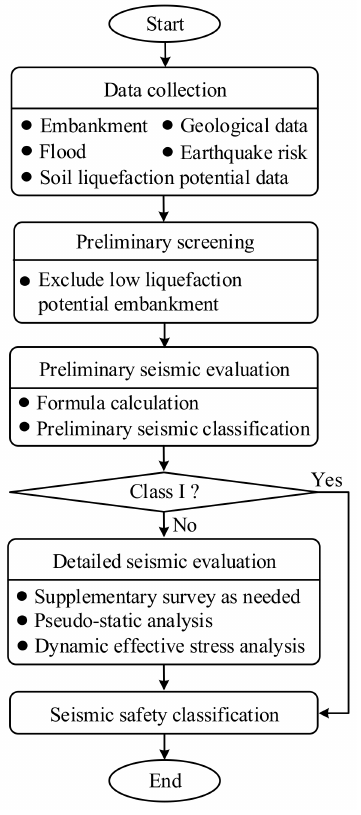
Figure 3. Seismic classification process of river